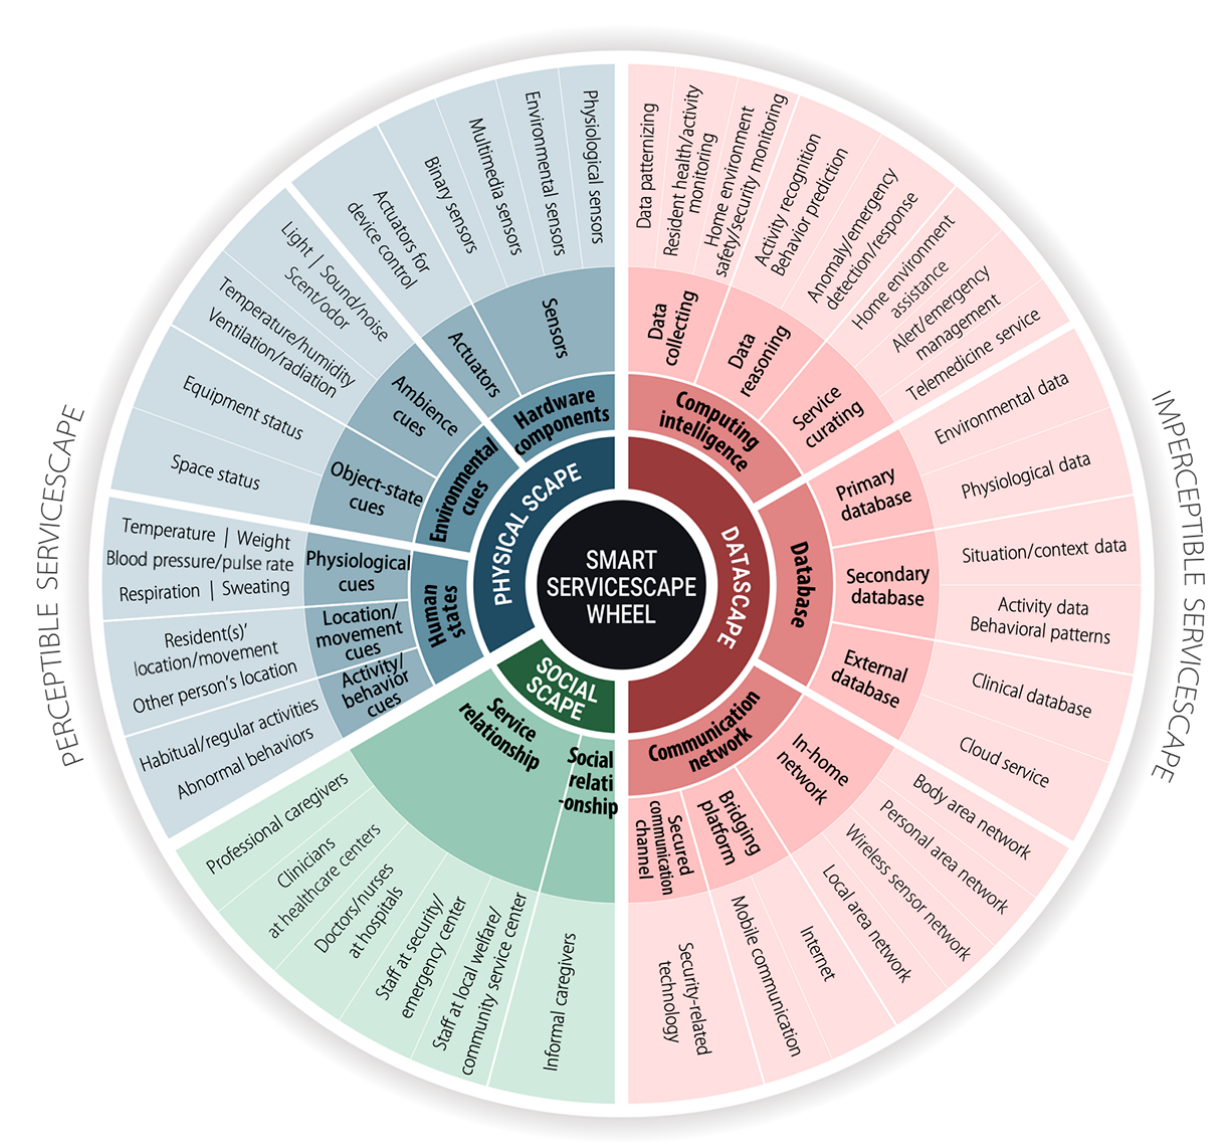
Figure 1. Smart servicescape wheel for smart homes for health care